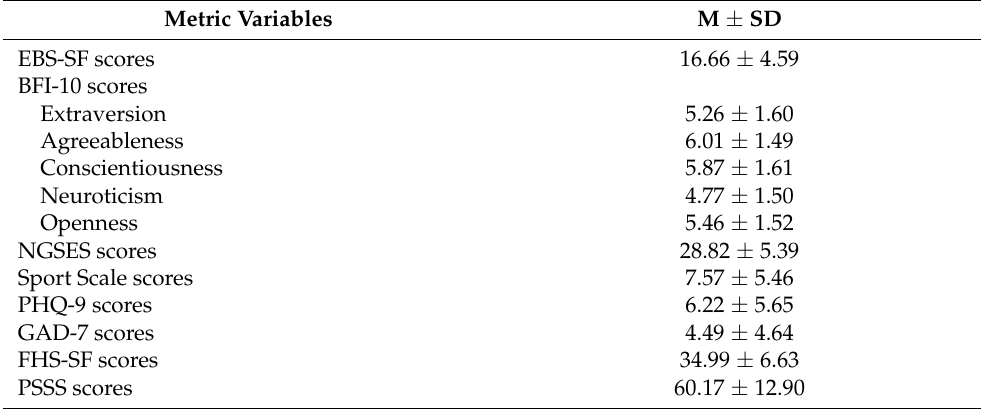
Table 2. The statistical description of metric